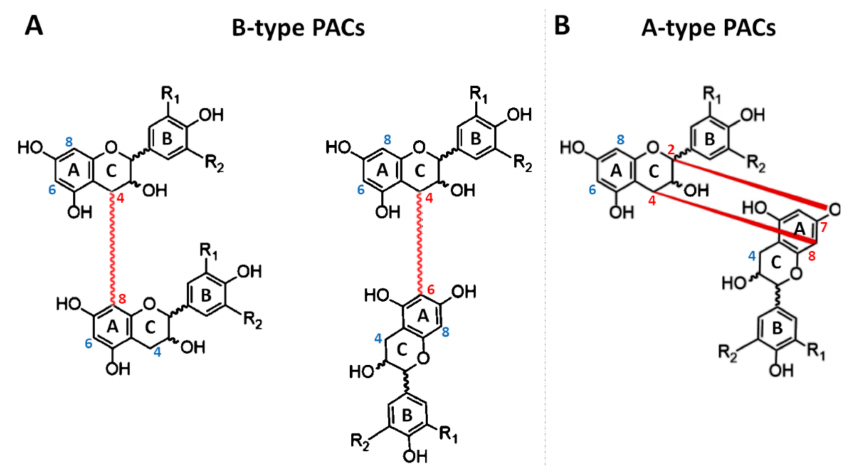
Figure 2. Linkage (red) that allows the polymerization of two monomers of flavan-3-ols, leading to the formation of B-type ( A ) or A-type ( B )